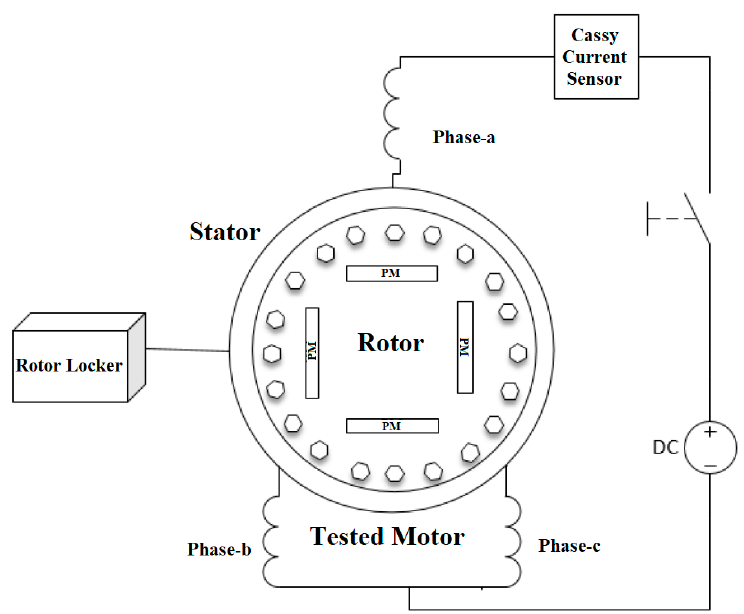
Figure 11. Schematic diagram of step DC test.